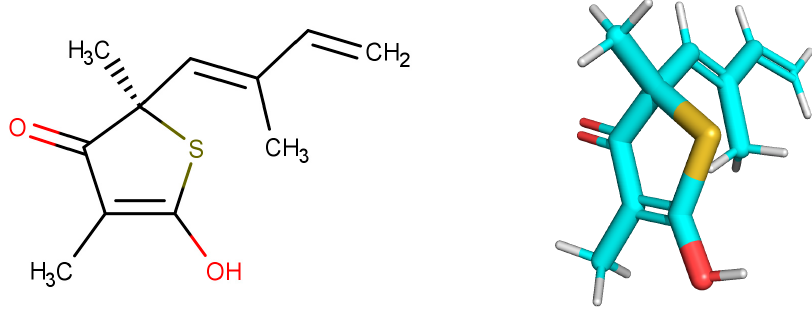
Figure 1. 2D and 3D structures of thiolactomycin (TLM). Figure 1 . 2D and 3D structures of thiolactomycin (TLM).